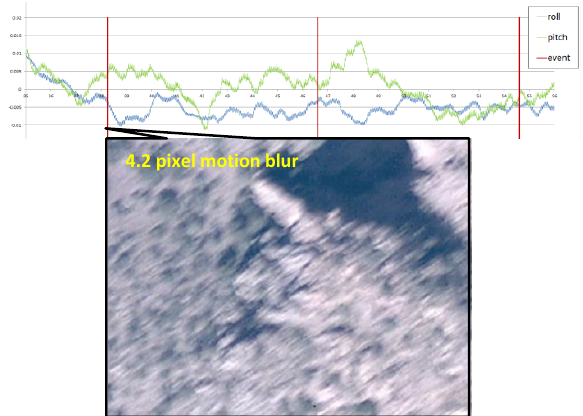
Figure 1 Roll and pitch graph and corresponding image with angular motion blur